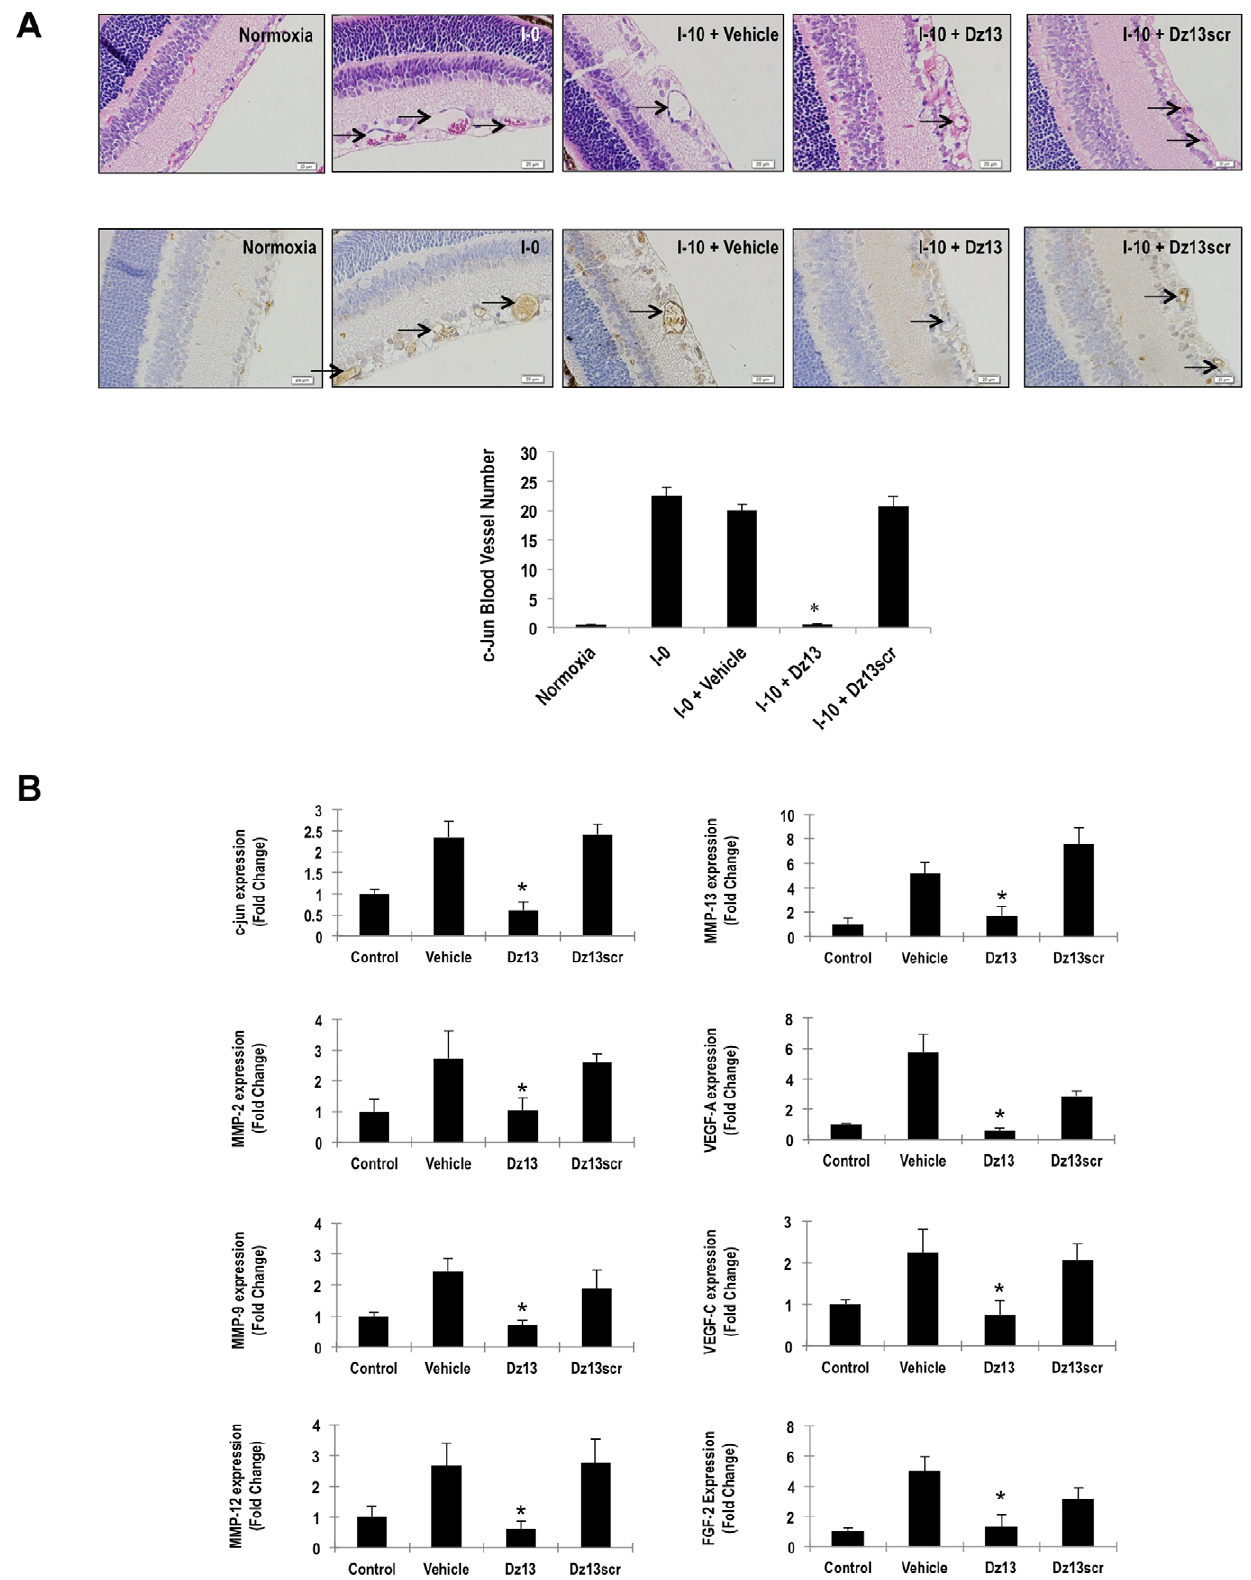
Figure 2. Dz13 inhibits c-Jun, FGF-2, VEGF-A, MMP-2 and MMP-9 expression in eyes of OIR mice. ( A ) Immunohistochemical analysis for c-Jun immunoreactivity in the retina of I-10 mice treated on I-0 with Dz13, Dz13scr or vehicle. Where indicated, IgG was used as the primary antibody as a negative control. Blood vessels are denoted by arrows. n=6–8 eyes per group. ( B ) qPCR analysis on eyes of I-10 mice for c-jun, FGF-2, VEGF-A,